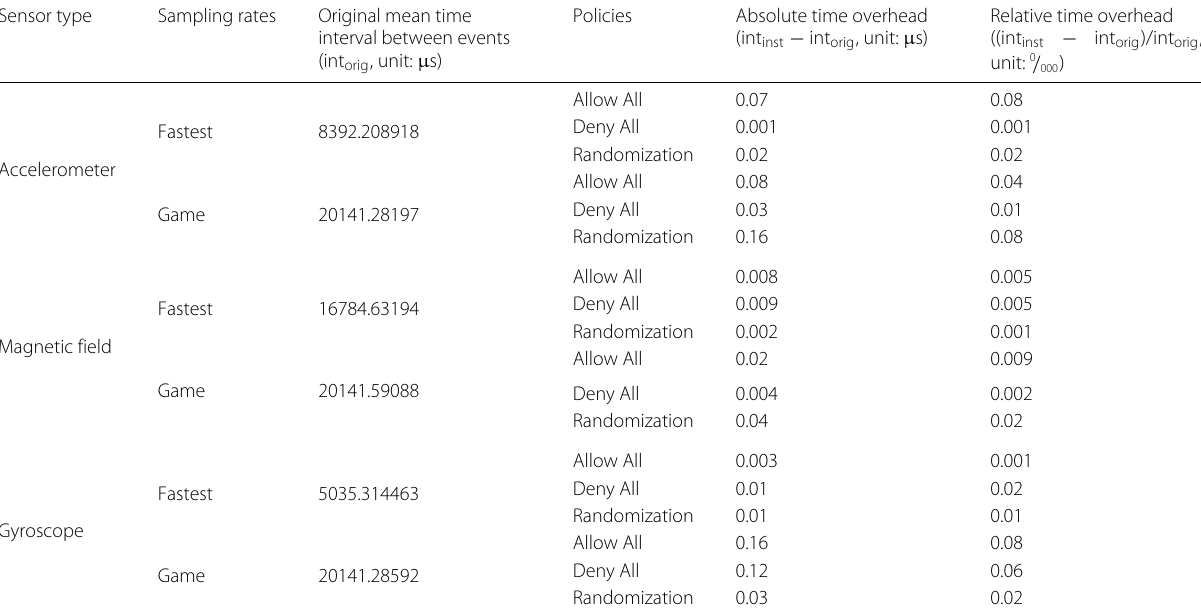
Table 2 Time overhead for different sensors at different sampling rate and under different policies Sensor